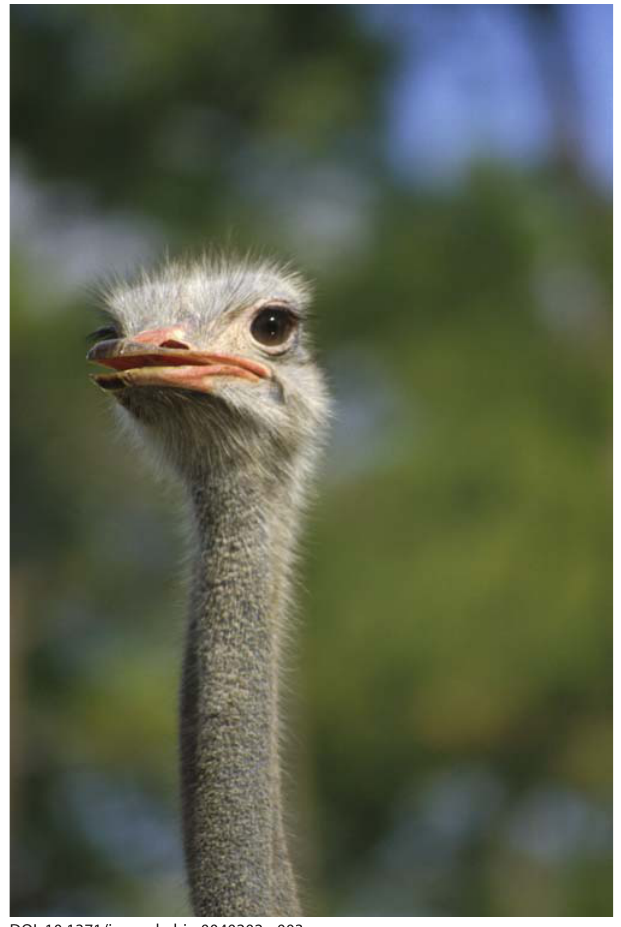
Figure 3. Ostrich